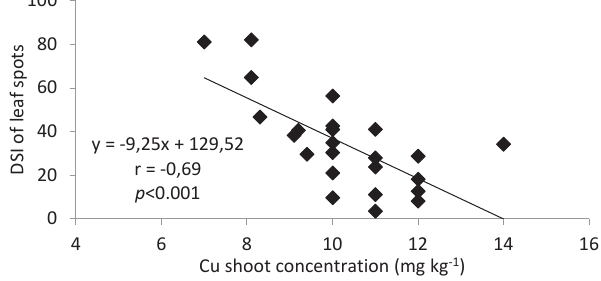
Fig. 2. Relationship between disease severity index (DSI) of leaf spots and Cu shoot concentrations of faba bean in three field experiments,